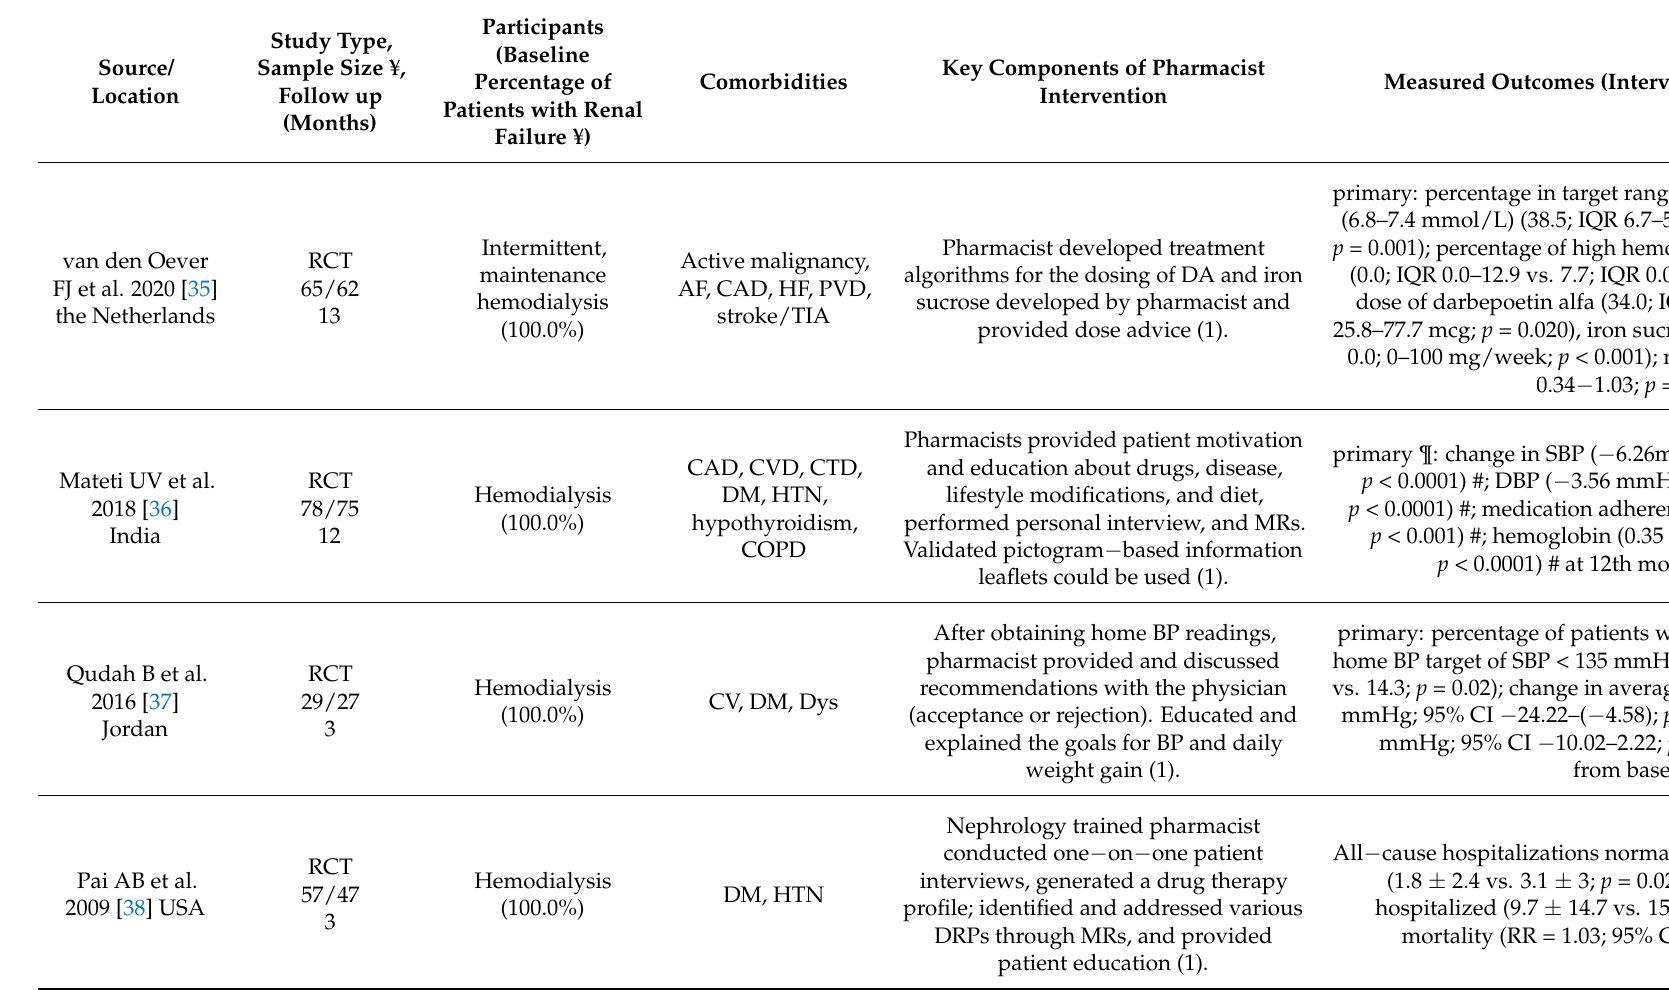
Measured Outcomes (Intervention vs. Usual